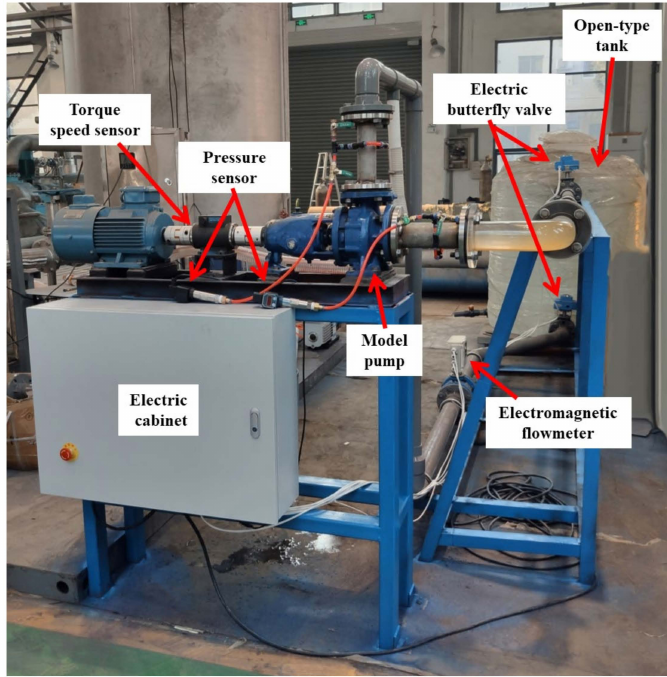
Figure 3. Centrifugal pump performance test unit.